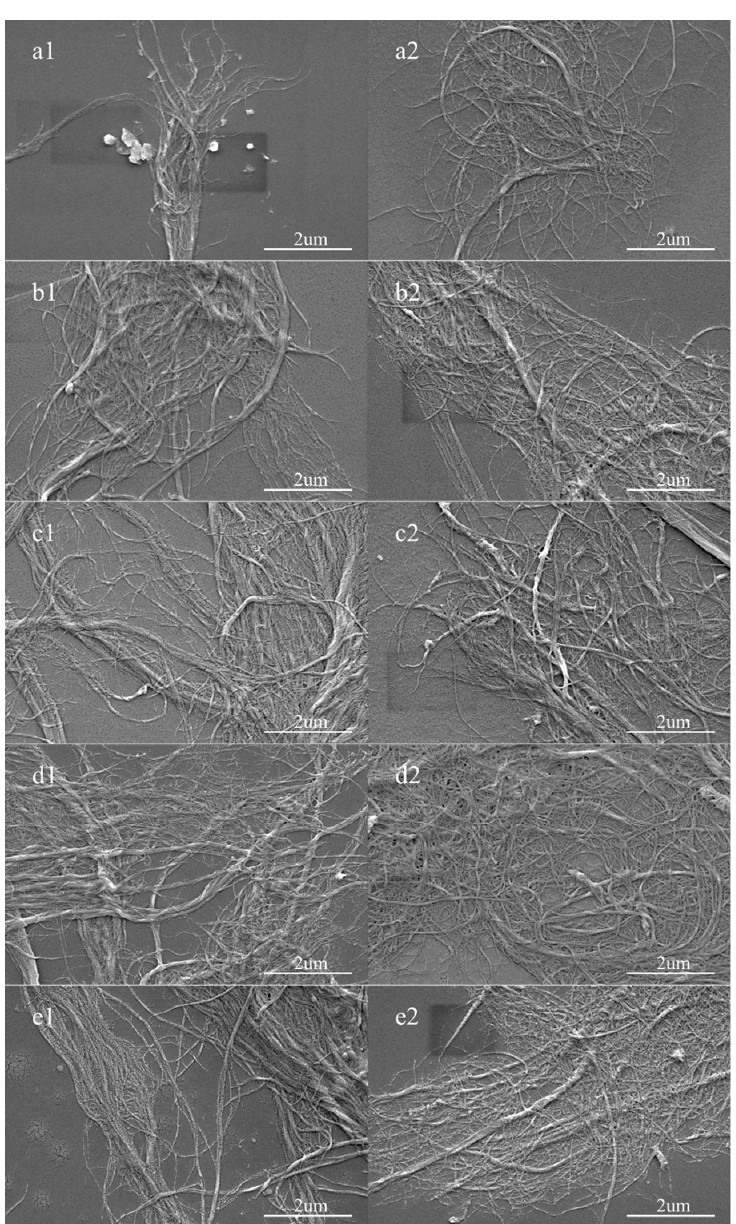
Figure 2. The scanning electron microscope (SEM) images of the cellulose nanofibrils before and after the homogenization: ( a1 , a2 ) bamboo pulp; ( b1 , b2 ) hardwood pulp; ( c1 , c2 ) softwood pulp; ( d1 , d2 ) cotton pulp; ( e1 , e2 ) hemp pulp (figure a2,b2 is taken from Reference [21]).